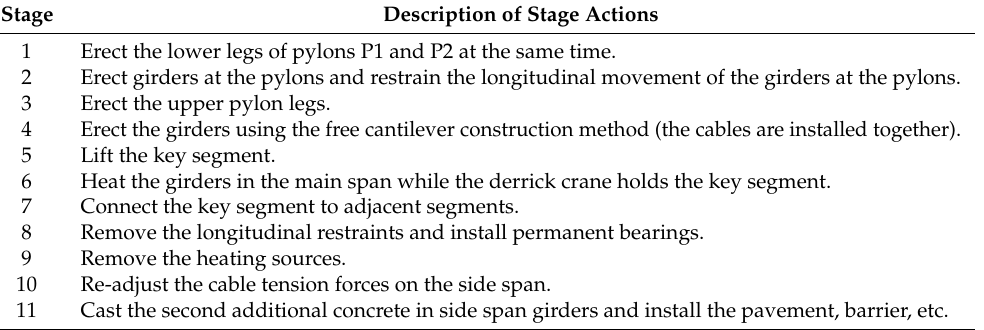
Table 3. Construction